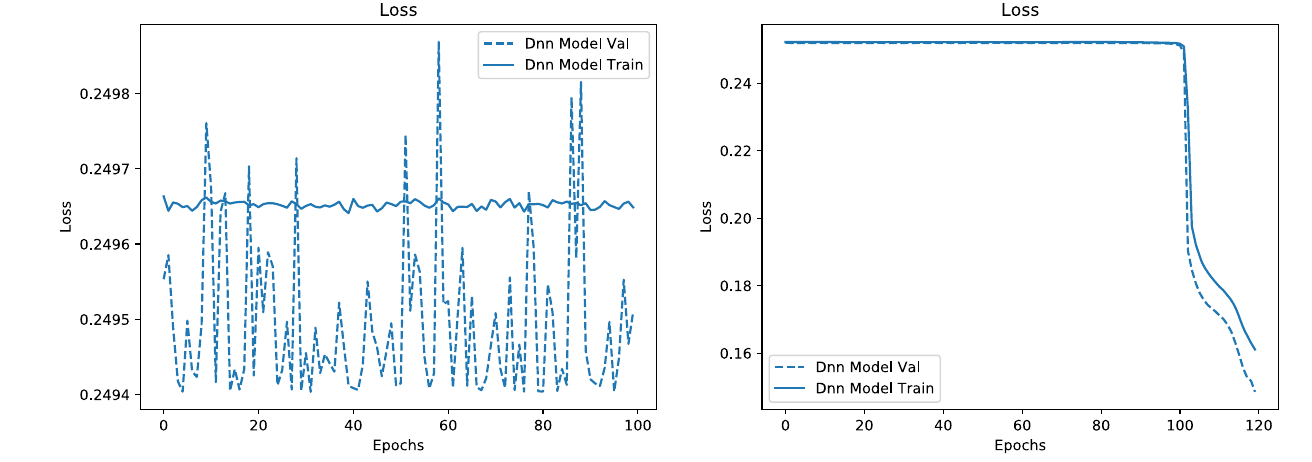
Fig. 18 Shape of the loss function related to a specific neural network topologyusedforregressioninthesemi-leptonicandfull-leptonicchan- nel. In this case the loss function is not converging, in particular in the first case the network is not improving its parameters at all giving a flat loss function and relatively unstable results for the validation dataset. In the second case the neural networking is not improving and only after